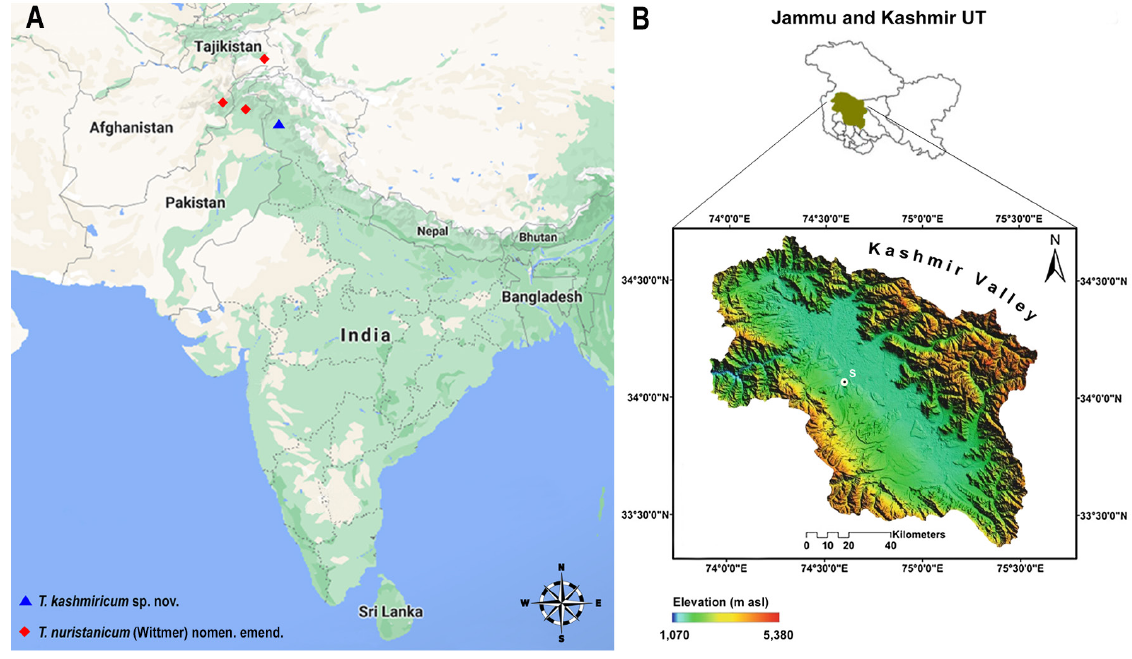
Fig. 8. A . Global distribution of species of Trypheridium Brancucci, 1985. B . Sampling site of Trypheridium kashmiricum sp.